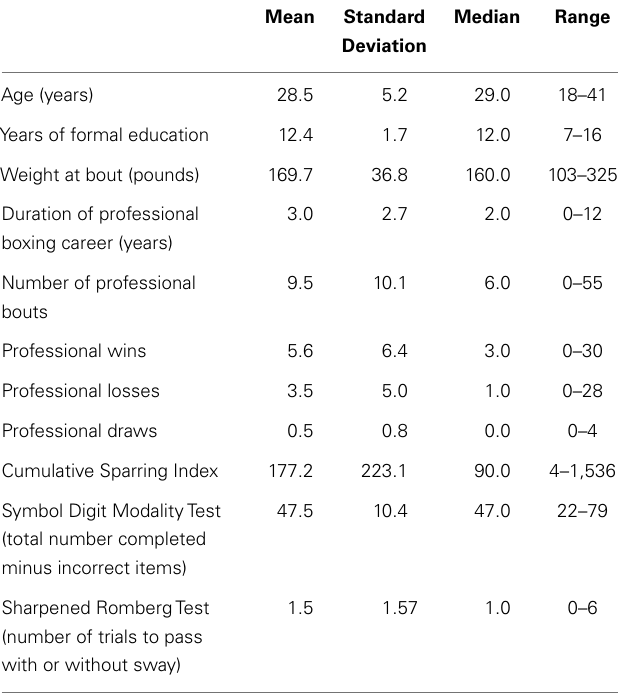
Table 1 | Participant Characteristics ( n = 237)